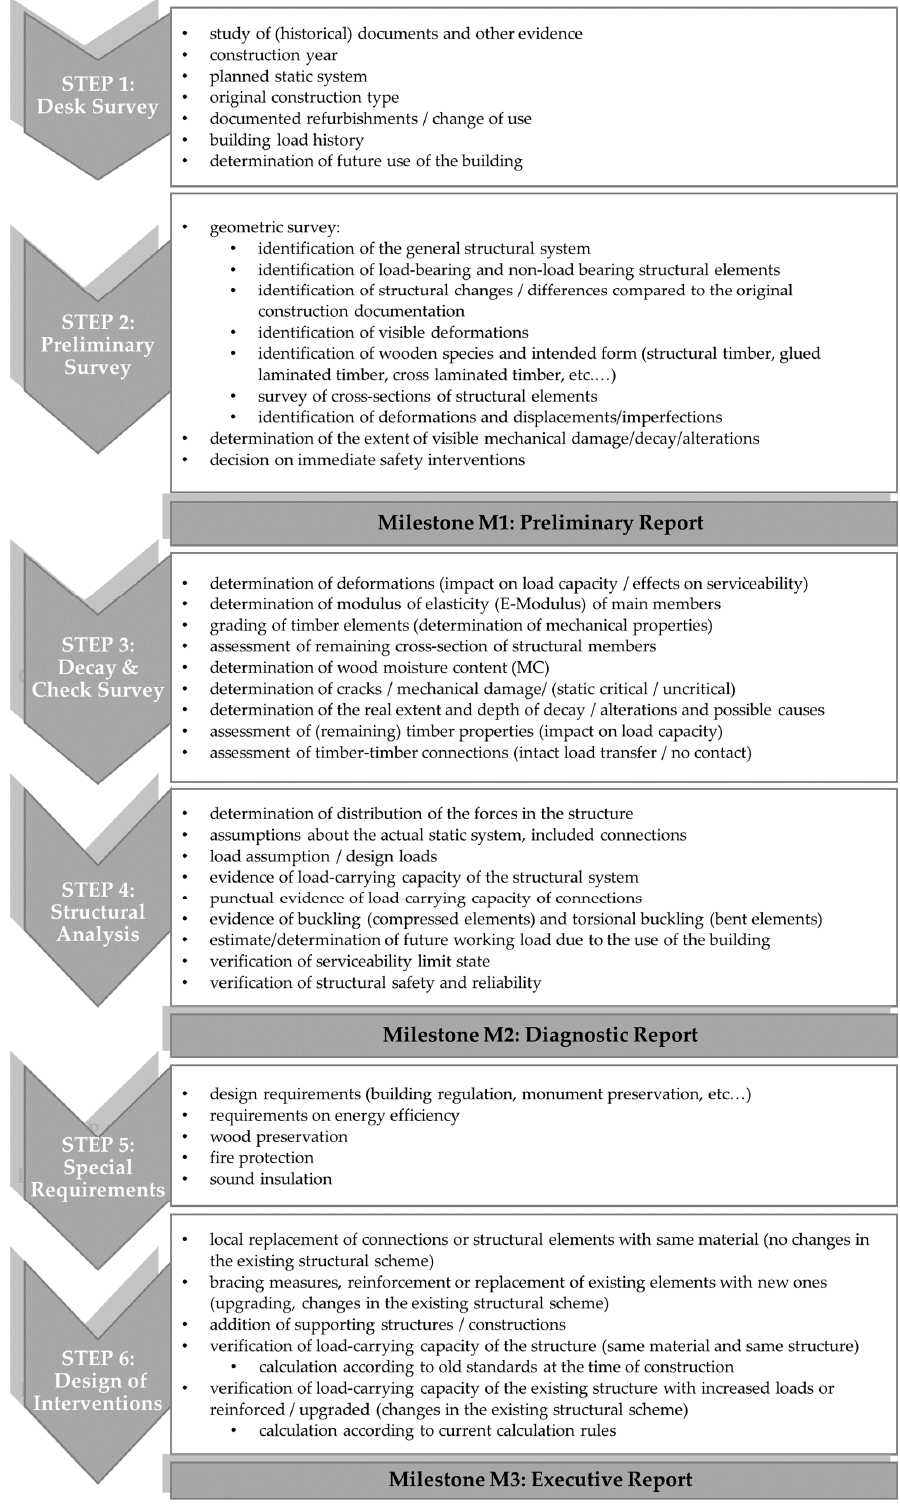
Figure 1. Six-steps assessment process of timber structures.